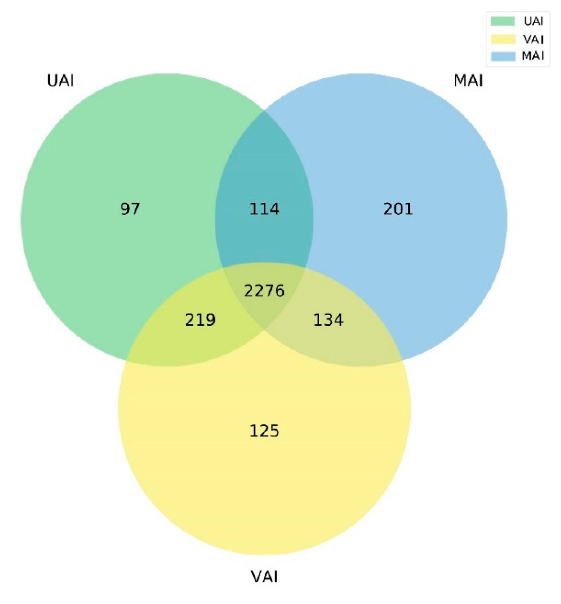
Figure 9. Distribution of OTUs in drip irrigation systems.